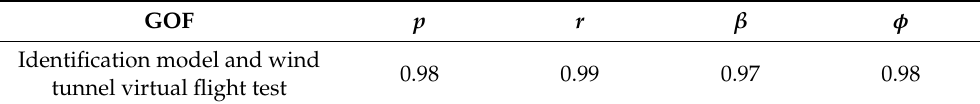
Table 5. The goodness of fit between the identification model and the test data. GOF p r β φ Identification model and wind 0.98 0.99 0.97 tunnel virtual flight test